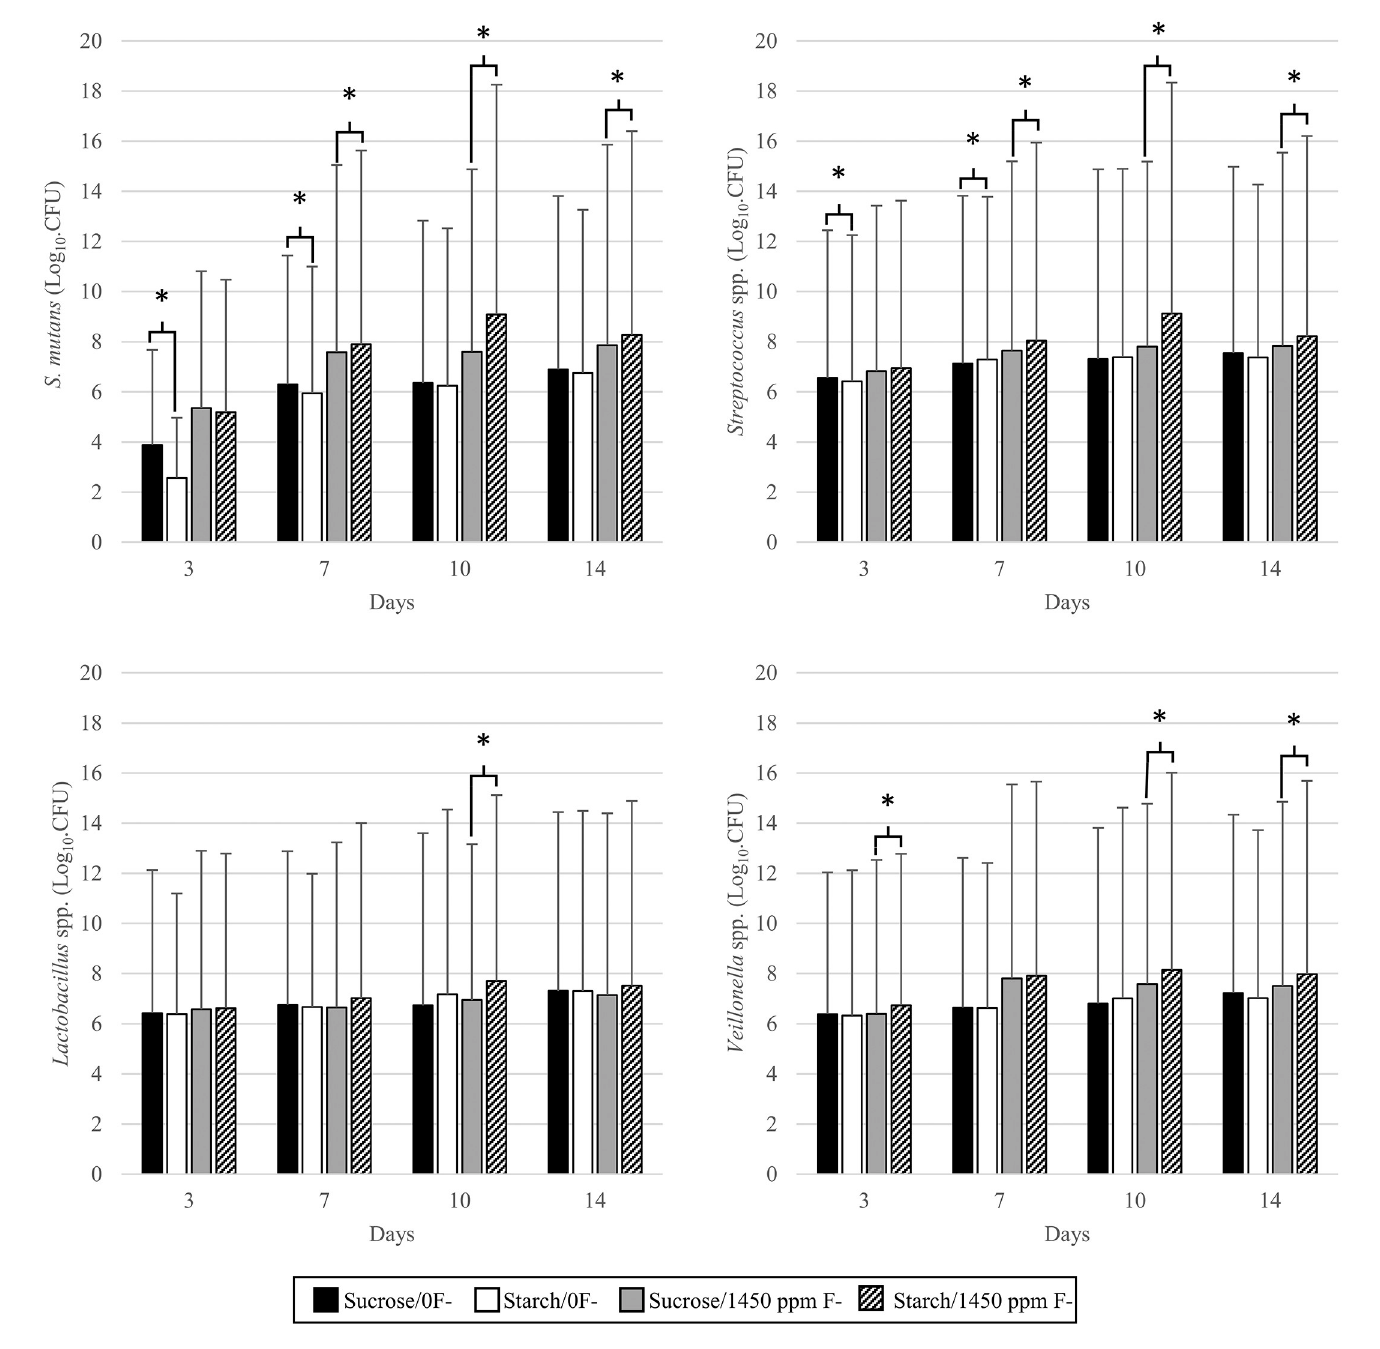
Fig 3. Bacterial enumeration. Viable counts of bacteria exposed to either 2% sucrose or 2% starch eight times daily. Error bars represent standard deviation of the sample set. � Denotes significance. https://doi.org/10.1371/journal.pone.0258881.g003 significant difference between the two conditions despite the discs exposed to sucrose having a higher fluorescence loss throughout (P > 0.05). For all time points the sample size of enamel discs was n = 10 except for a loss of a sucrose exposed disc on day 7 (n = 9).